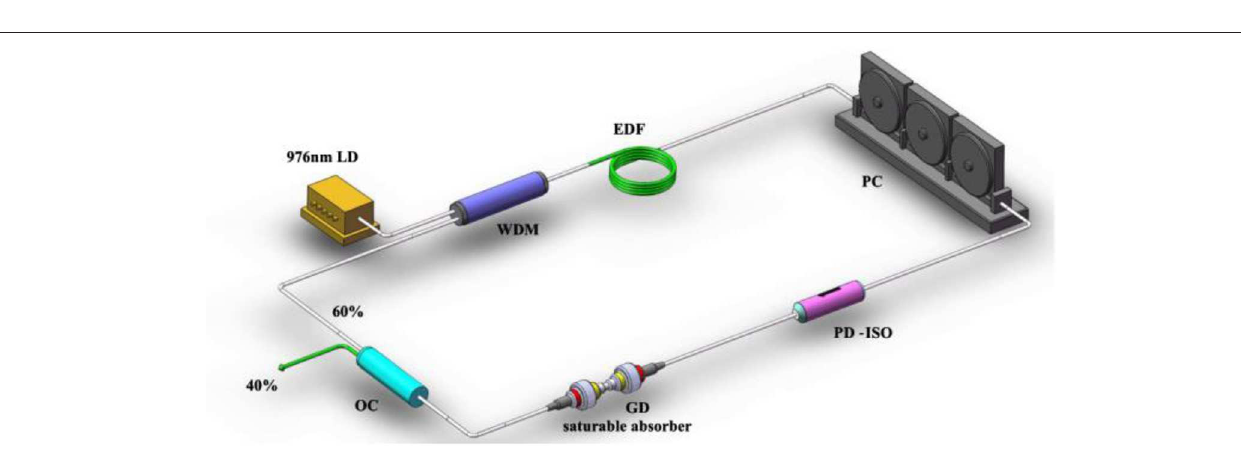
FIGURE 4 | Experimental setup of the hybrid erbium-doped mode-locked fiber